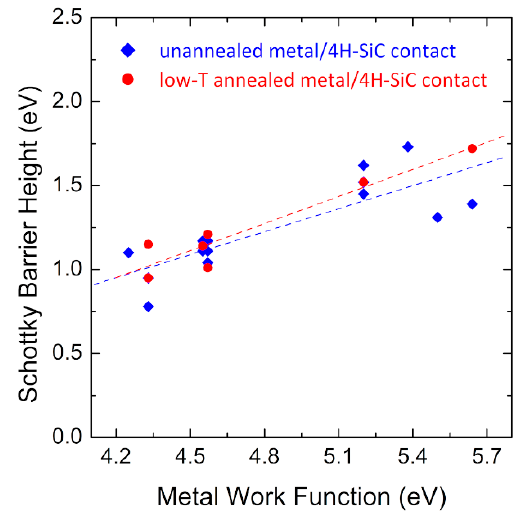
Figure 3. Experimental dependence of the barrier height Φ B on the metal work function W M in unannealed and low-temperature annealed metal/n-type 4H-SiC systems. All the reported barrier values were determined by I–V characterization of Schottky diodes. Data are taken from Refs. [21–44].